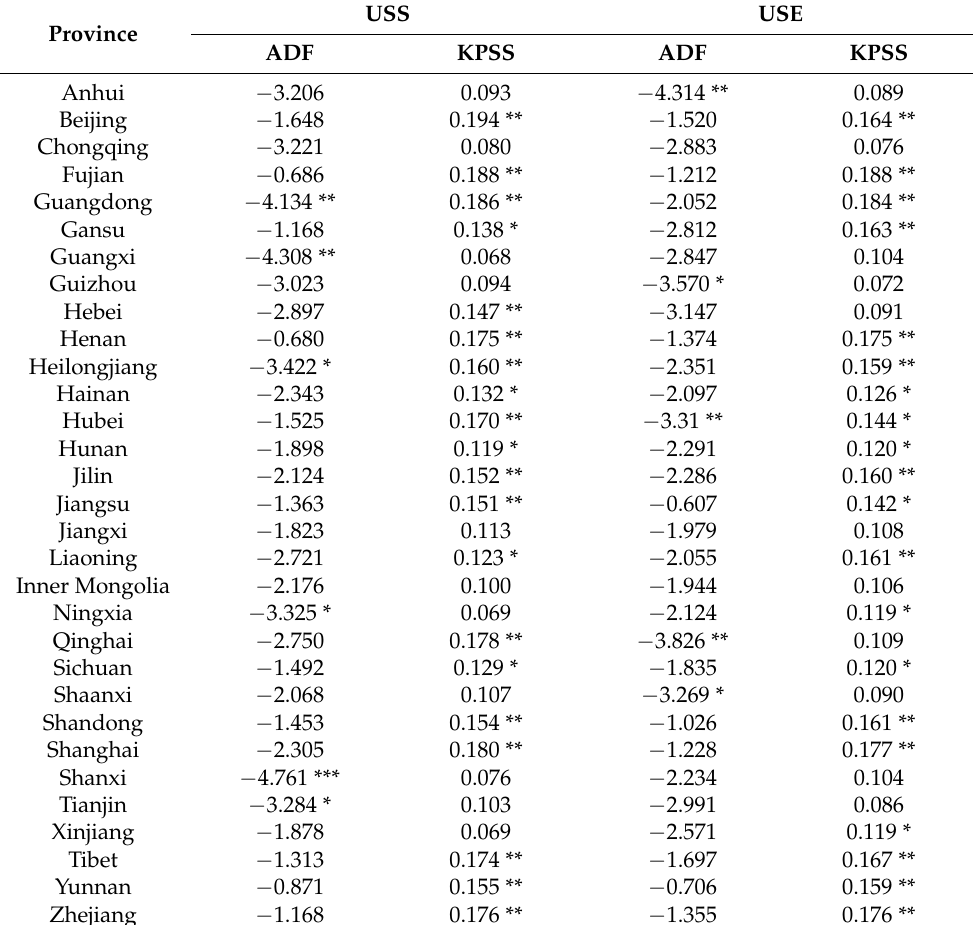
Table 4. Univariate unit root